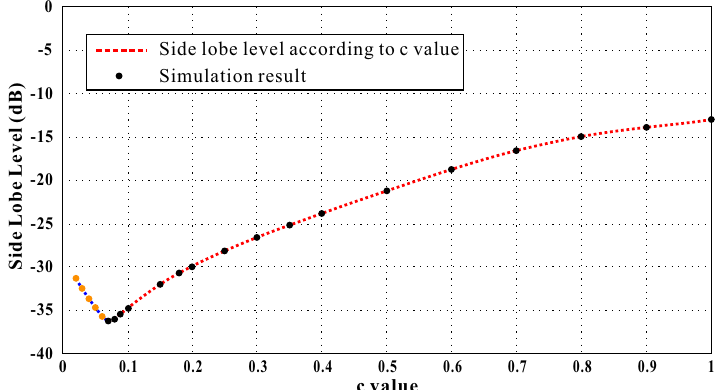
Figure 10. Relation graph between sidelobe level and variable c of Bernstein polynomial.